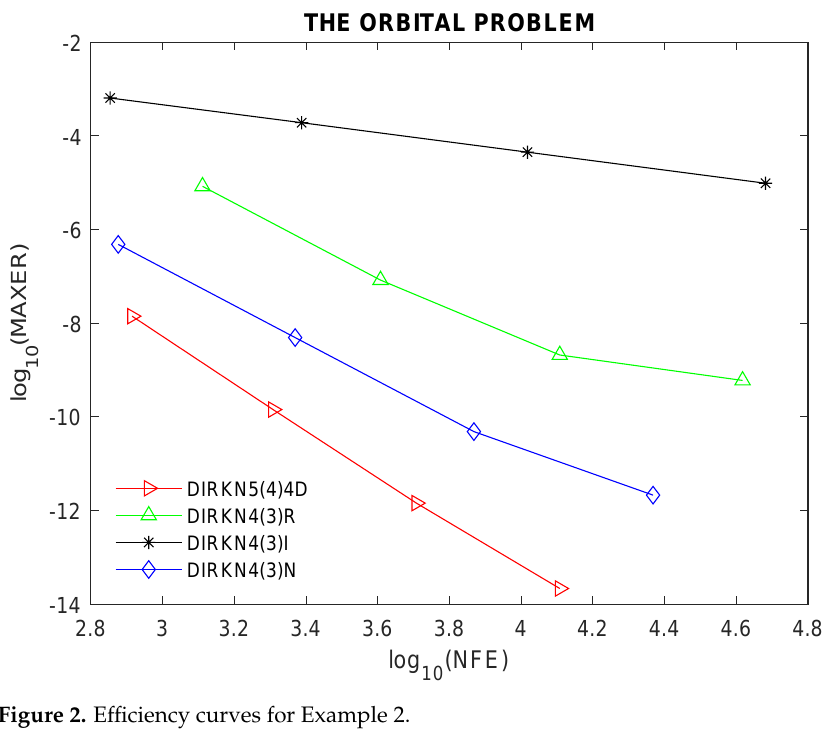
Figure 2. Efficiency curves for Example 2.